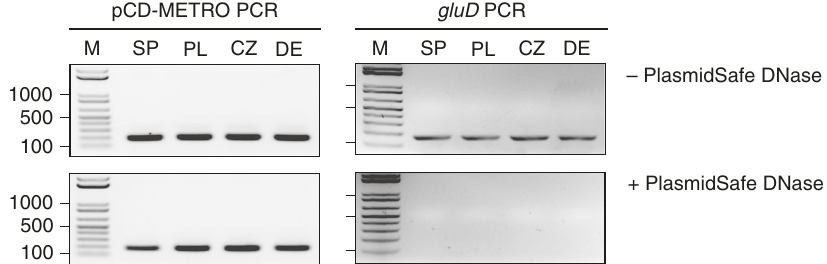
Fig. 3 pCD-METRO is internationally disseminated. PCR analysis of strains 7032989 (RT010, Spain) (SP), LUMCMM190960 (RT027, Poland) (PL), LUMCMM19 0880 (RT010, Czech Republic) (CZ), and P016134 (RT010, Germany) (DE). The product of plasmid-speci fi c ampli fi cation (targeting ORF8) or chromosomal-speci fi c ampli fi cation ( gluD ) before and after PlasmidSafe DNase treatment are shown. Source data are provided as a Source Data fi